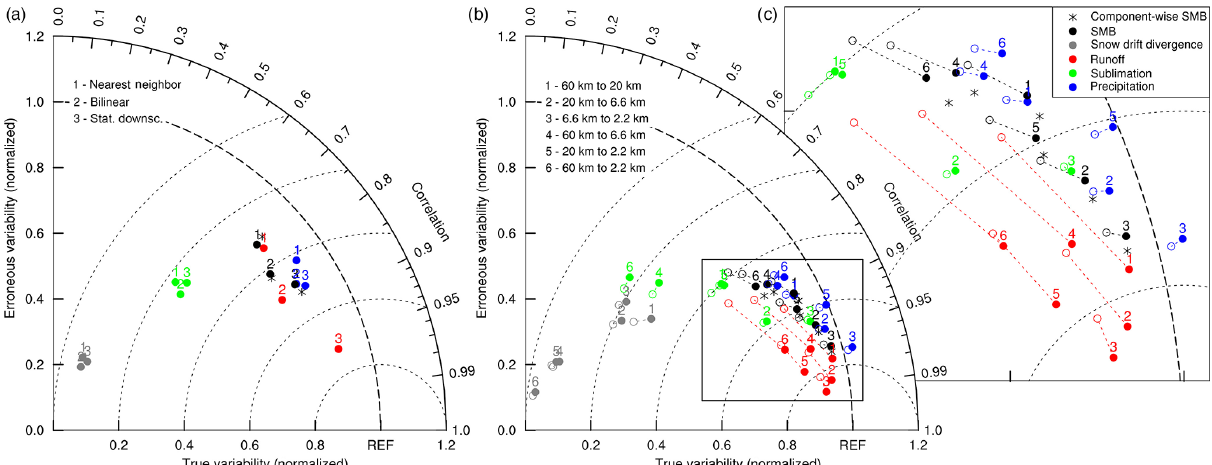
Figure 5. Taylor diagrams of the represented model variability for SMB and its components for (a) various refining procedures from 60 to 6.6km and (b) bilinear (open circles) and statistical downscaling (filled circles) across all different model simulations, respectively, connected by dotted lines. (c) Zoom of the boxed point cluster in (b) . The legend in (c) applies to all panels. The horizontal location in the Taylor graph gives the fraction of the true variability reproduced by the model; the vertical location is the amount of erroneous variability as fraction of the standard deviation of the reference